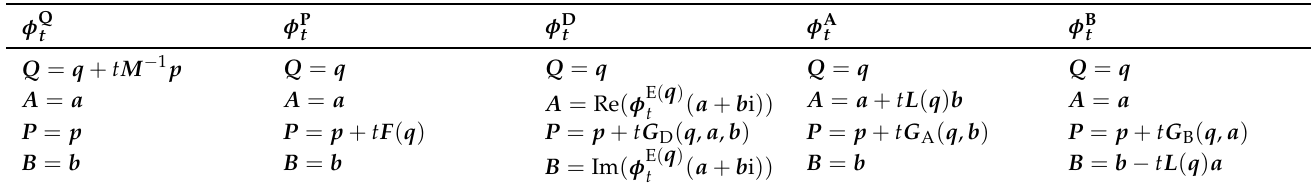
, φ P , φ D , φ A , and φ B . t t t t t